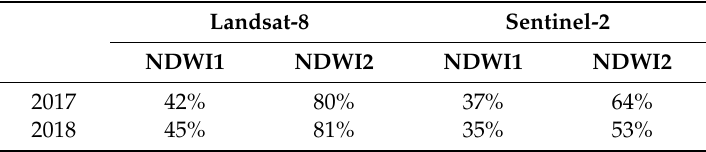
Table 6. Percentage statistics of NDWI threshold greater than